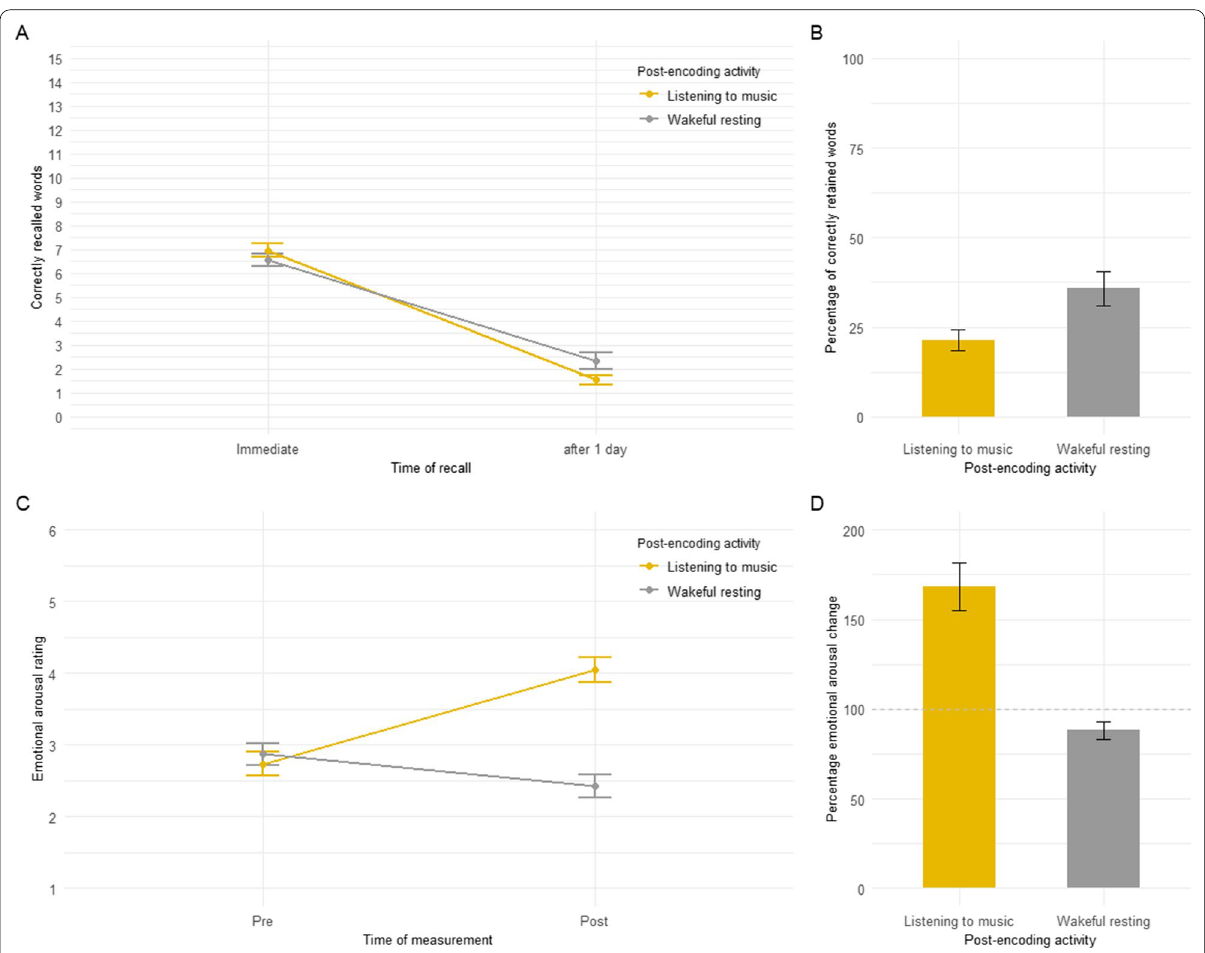
Fig. 2 A Mean number of words correctly recalled (out of 15 per word list) as a function of the post-encoding activity (wakeful resting [grey] vs. listening to music [yellow]) and time of recall (immediate vs. after 1 day). B Mean percentage-retention scores as a function of post-encoding activity (wakeful resting [grey] vs. listening to music [yellow]). Percentage-retention scores were calculated by dividing the number of correctly recalled words in Session 2 by the number of correctly recalled words in Session 1 and multiplying the quotient by 100. C Mean emotional arousal ratings as a function of the post-encoding activity (wakeful resting [grey] vs. listening to music [yellow]) and time of measurement (before learning the word list [pre] vs. after the post-encoding activity [post]). D Percentage emotional arousal change scores as a function of post-encoding activity (wakeful resting [grey] vs. listening to music [yellow]). Percentage emotional arousal change scores were calculated by dividing participant’s emotional arousal rating before encoding a word list divided by the emotional arousal rating after the respective post-encoding activity (wakeful resting vs. listening to music) multiplied by 100. Dashed helpline: 100% indicates no change in the mean pre- to post emotional arousal ratings. Error bars represent standard errors of the